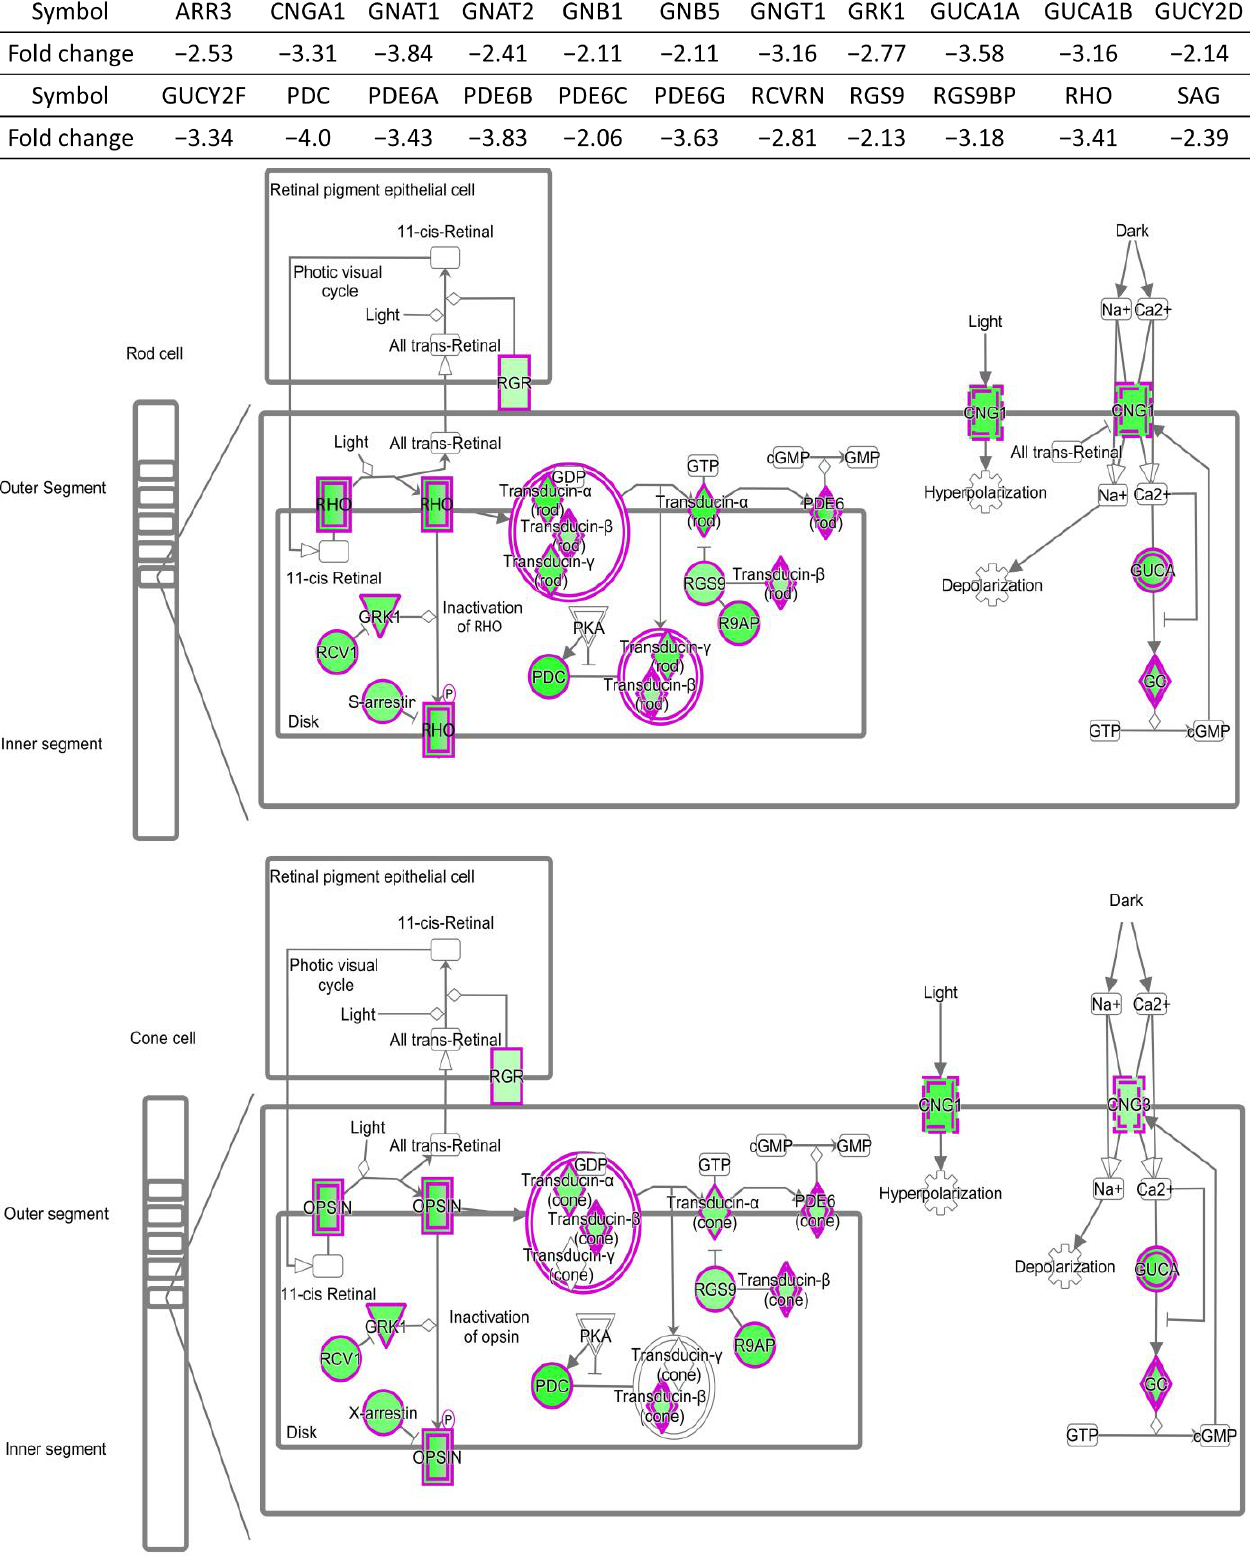
Figure 2. Downregulation of 22 differentially expressed genes linked to the phototransduction pathway of rod and cone cells.